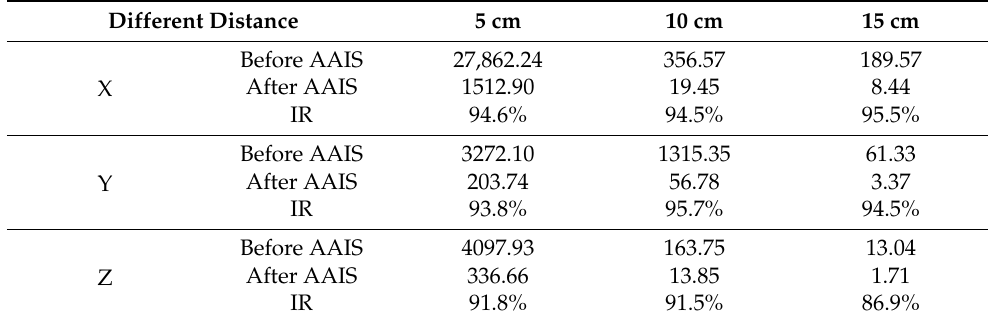
Table 8. The standard deviation (nT) at different distances.